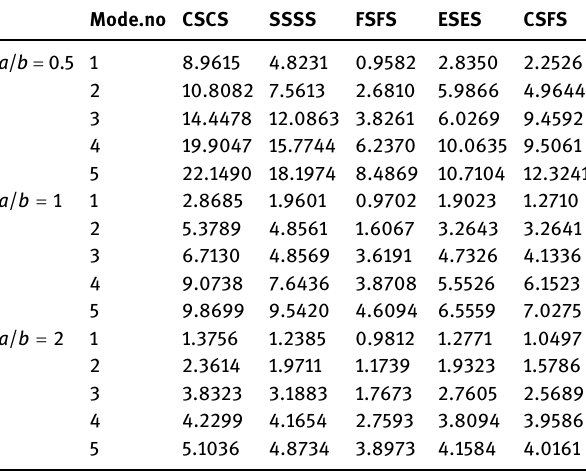
Table 4: Nondimensional frequency parameters of rectangular